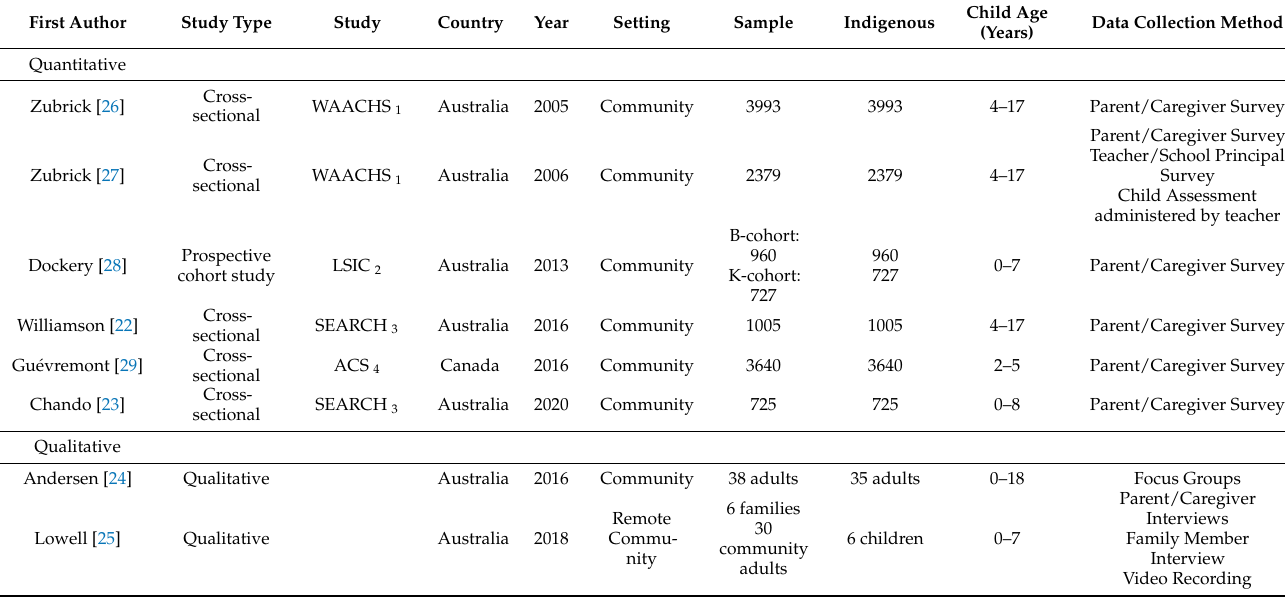
Table 1. Characteristics of the included studies (n =